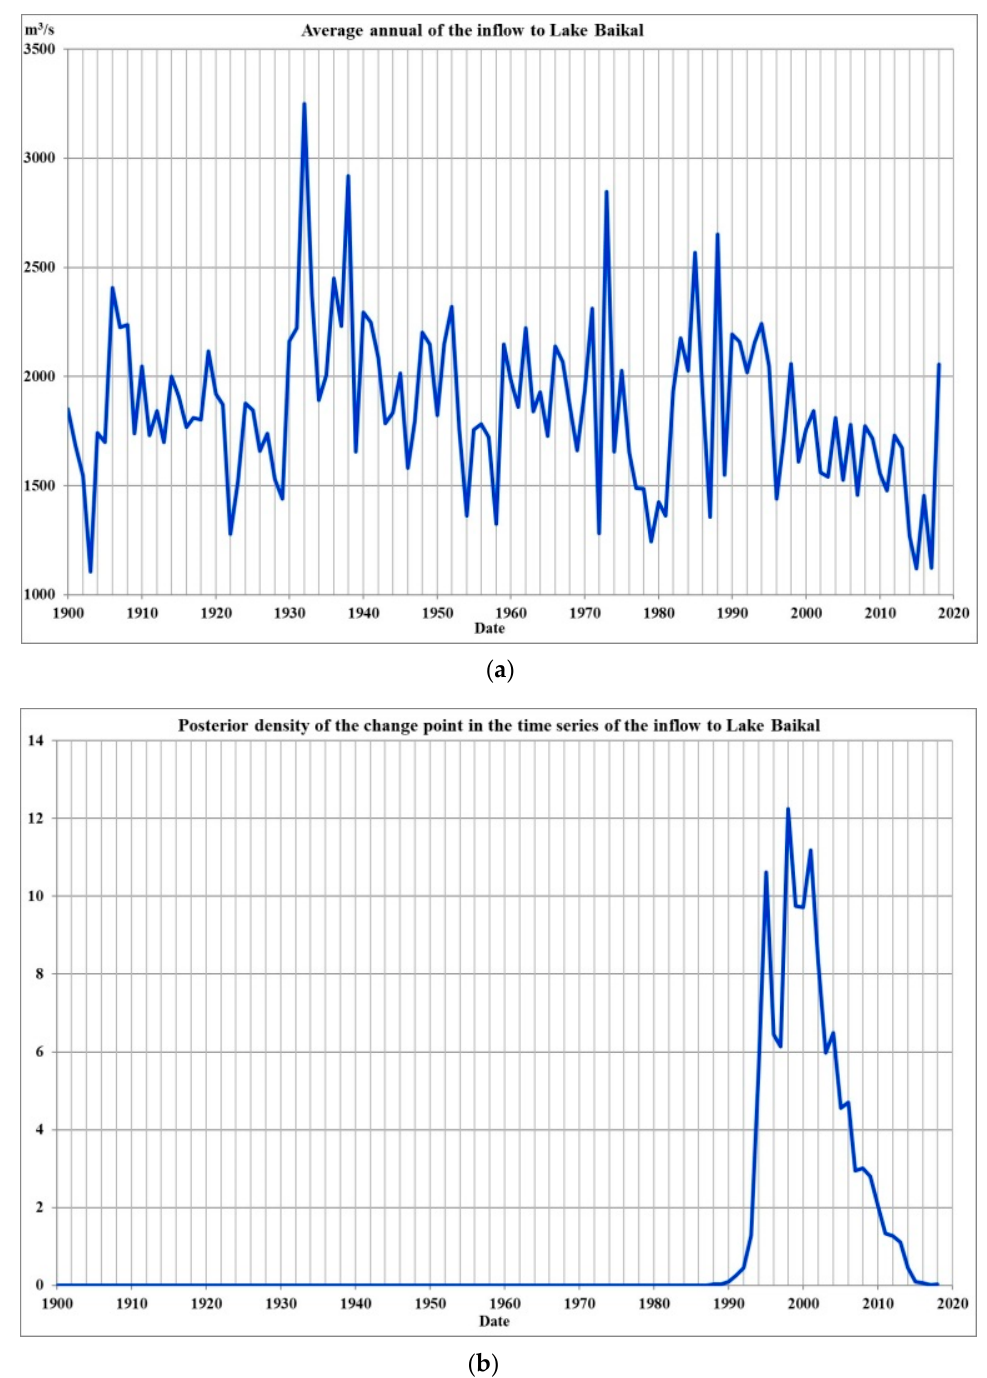
Figure 5. Chronological graph of the inflow average annual values of the Lake Baikal ( a ) and posterior density (Bayesian estimate) of the change point in the inflow time series to Lake Baikal ( b ).